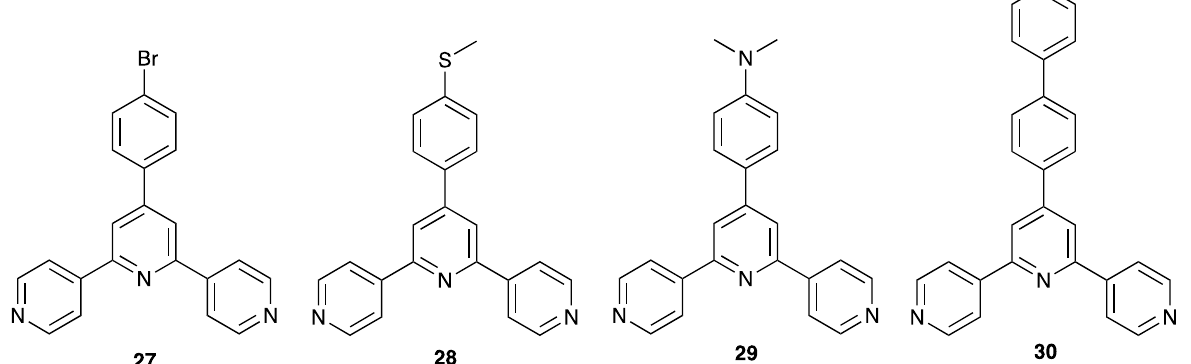
Scheme 9. Ligands that form [Zn 2 ( μ‐ OAc) 4 (4’ ‐ X ‐ 4,2’:6’,4” ‐ tpy)] n type 1D ‐ zigzag polymers. See Scheme 6 for ligand 14 .